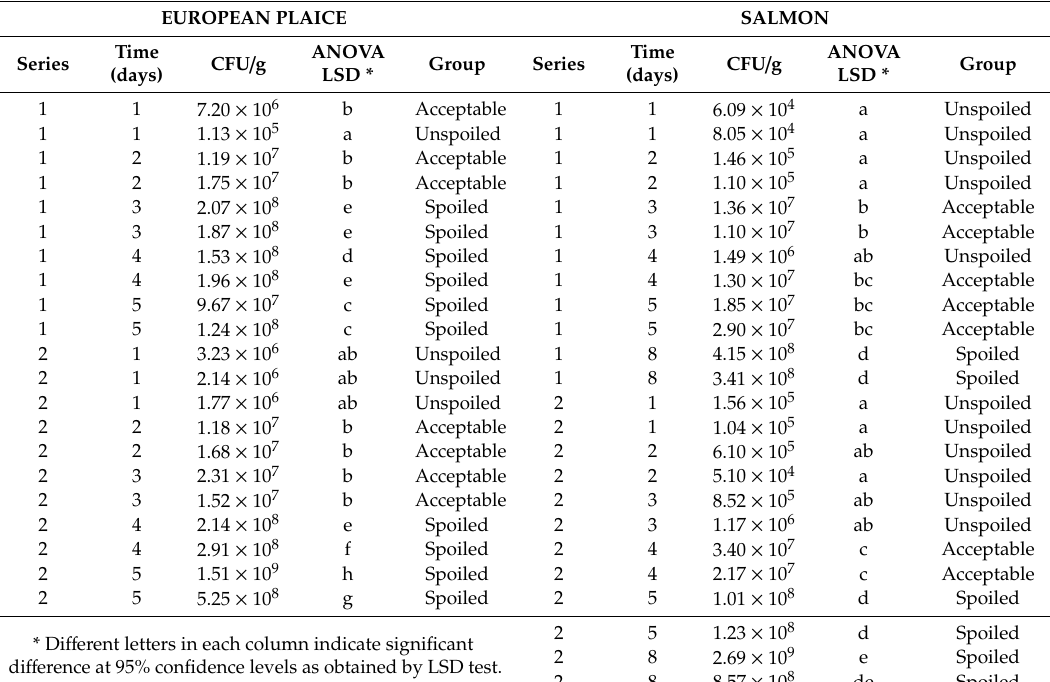
Table 5. One-way ANOVA and LSD test applied on microbiological data (TVC, CFU / g of product) collected on plaice and salmon